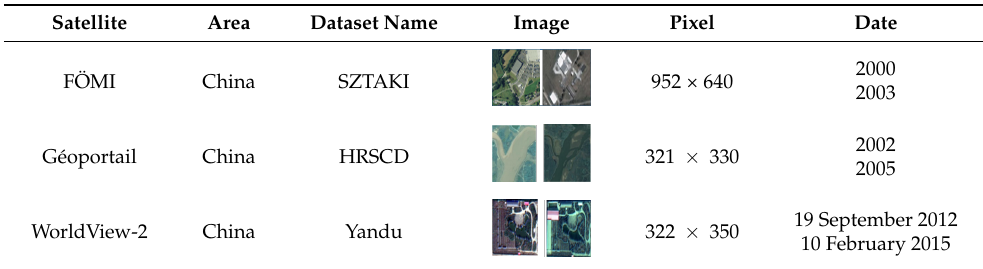
Table 5. Illustration of local area